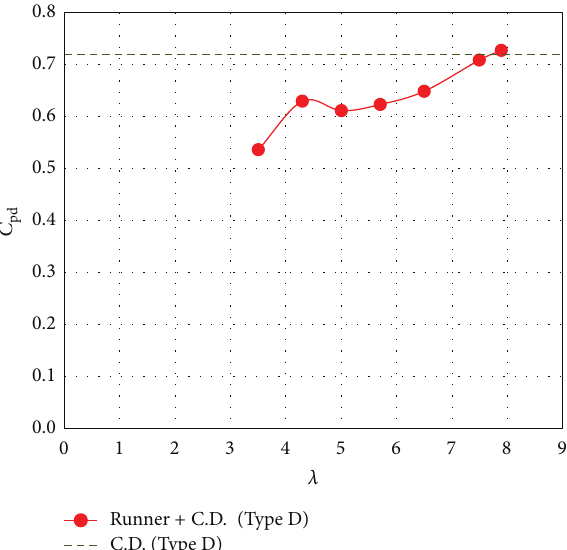
Figure18:Correlationbetweenthetipspeedratioandthebackpres- sure